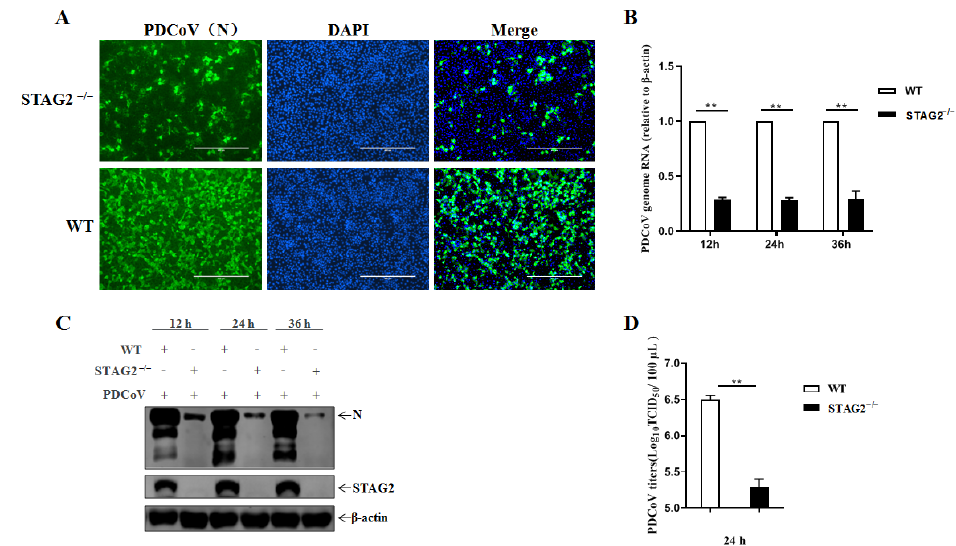
Figure 3. STAG2 is involved in the replication of PDCoV. ( A ) WT and STAG2 − / − cells were infected with PDCoV at an MOI of 1, twenty four hours post infection, cells were fixed and stained with anti-PDCoV-N mouse monoclonal antibody followed by probe with FITC-conjugated goat anti-mouse IgG. The representative results were displayed by three different channels (PDCoV-N, DAPI, and overlay) for each treatment; ( B ) WT and STAG2 − / − cells were infected with PDCoV at an MOI of 1, PDCoV N mRNA concentration was determined by quantitative RT-PCR at indicated time points post infection; ( C ) WT and STAG2 − / − cells were infected with PDCoV at an MOI of 1 followed by samples detection by Western blot at indicated time points post infection; ( D ) WT and STAG2 − / − cells were infected with PDCoV at an MOI of 1, twenty four hours post infection, virus yield was measured by TCID 50 . The results are representative of three independent experiments (the means ± SD). **, p < 0.01. The p value was calculated using Student’s t -tests.